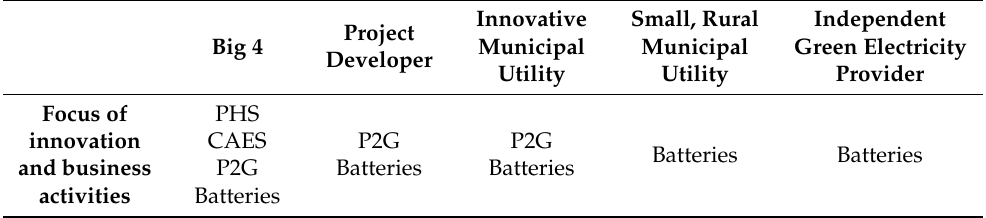
Table 2. Storage operator